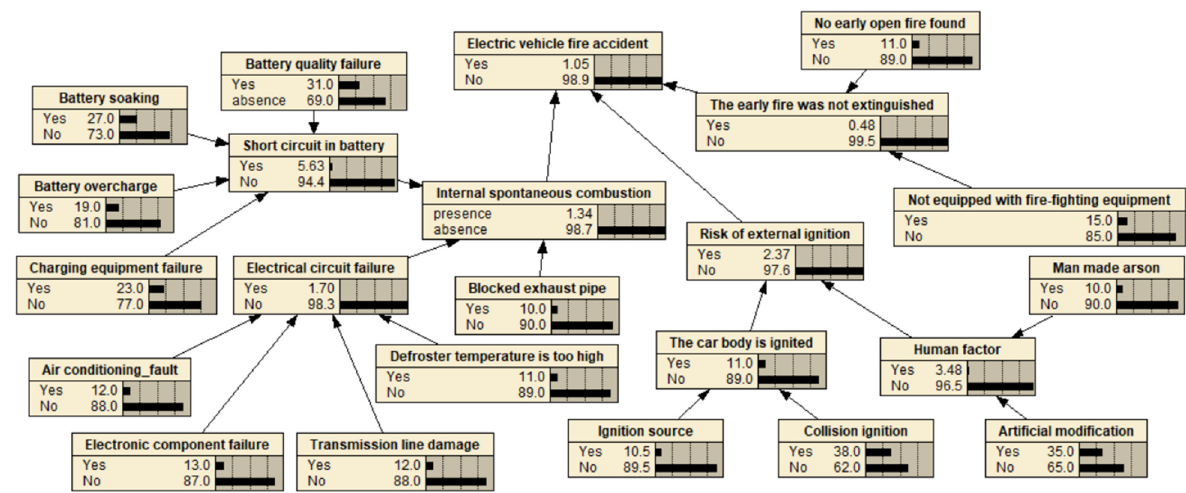
Figure 11. Bayesian model deduction of electric vehicle fire. According to the calculation of the Bayesian network, the fire accident rate of electric vehicles is about 0.0105. Because the node probability is evaluated by expert language and processed by fuzzy numbers, and all-electric vehicle fire data cannot be counted, the